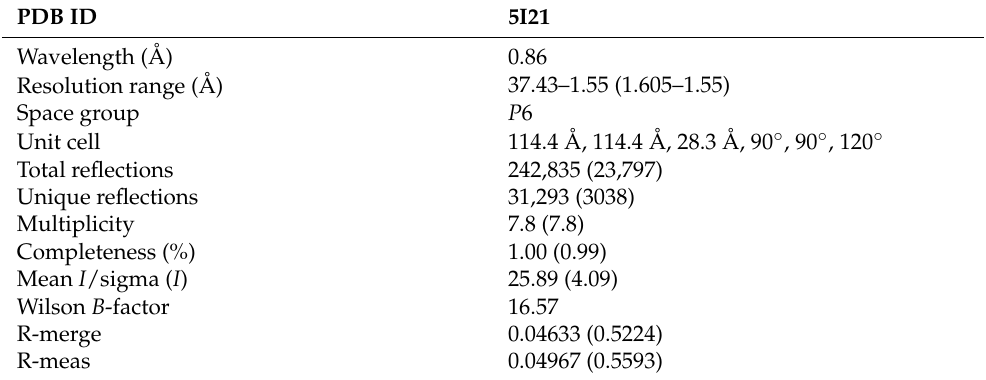
Table 3. X-ray data parameters and refinement statistics for the Pae Hfq Y55W mutant. Statistics for the highest-resolution shell is shown in